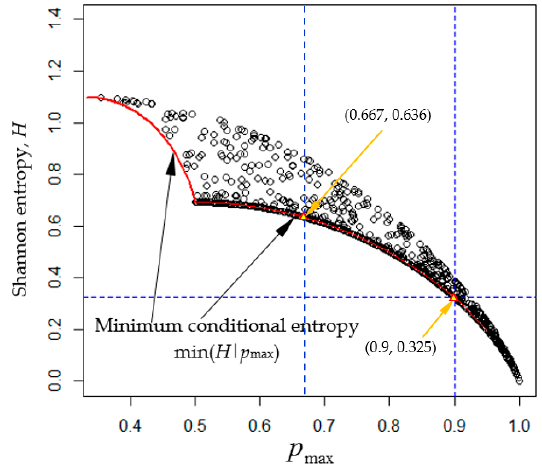
Figure 11. Relationship between the maximum class probability and Shannon entropy H .